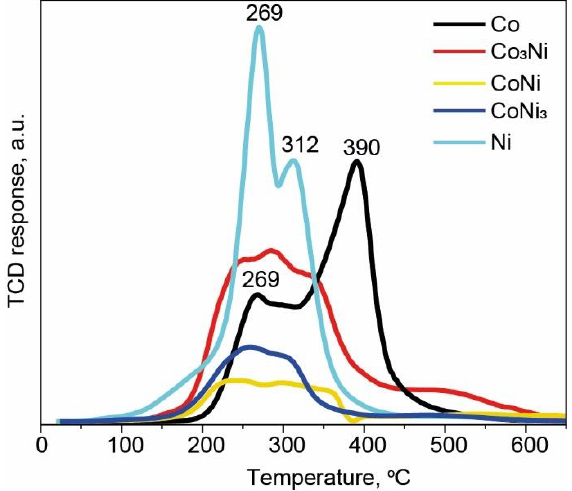
Figure 5. H 2 -TPR profiles of Co, Ni, and bimetallic Co x Ni 1 – x